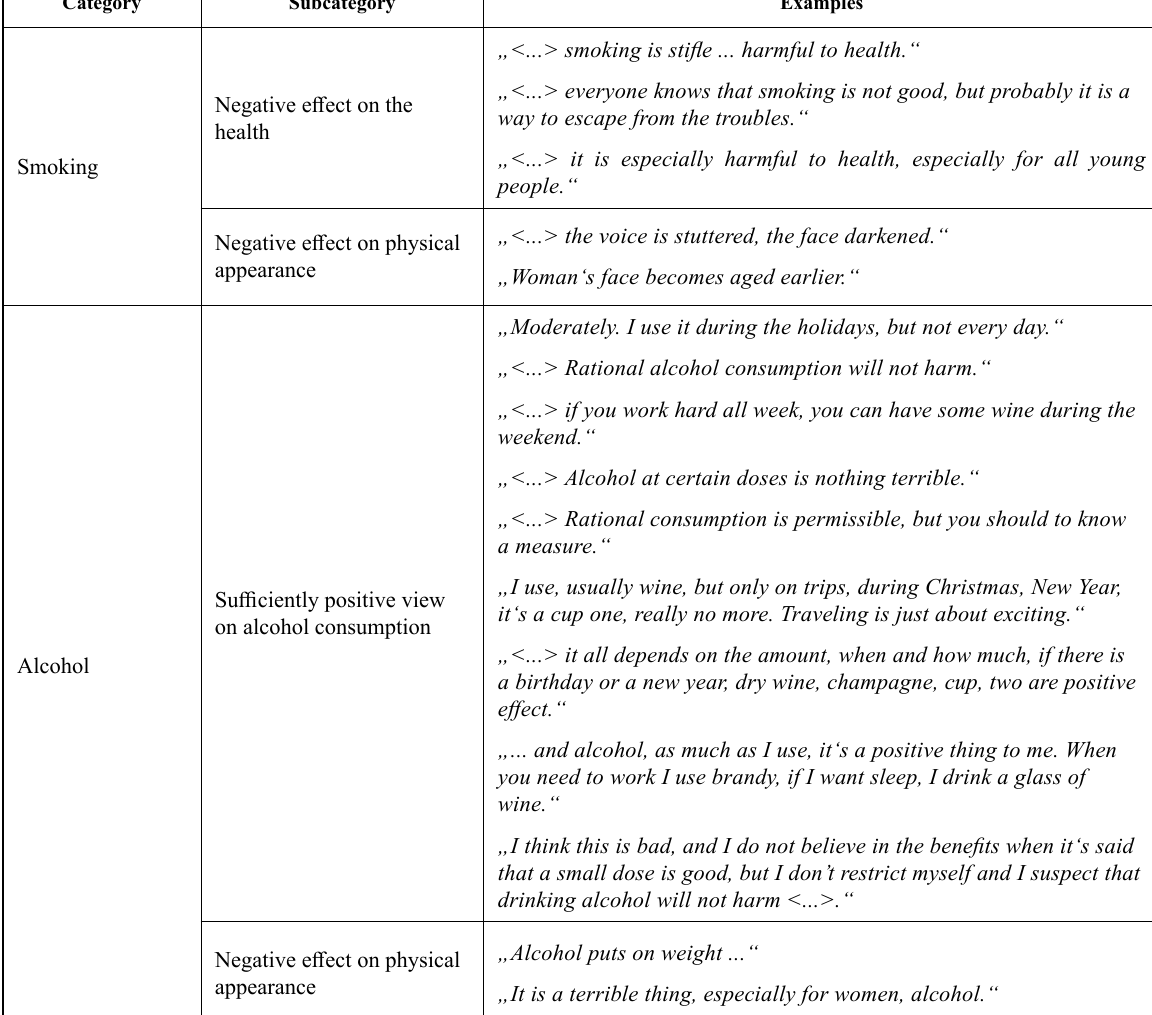
Table 2. Perception of harmful